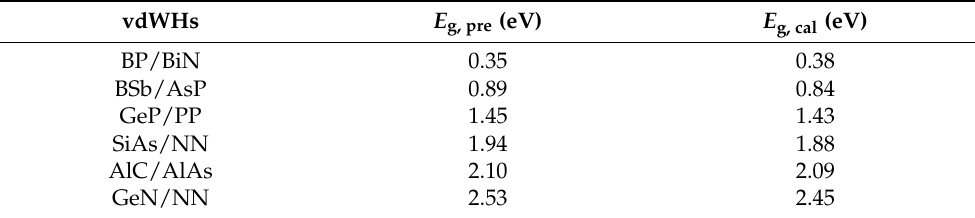
Table 2. Comparisons of the SISSO-predicted band gaps and those calculated by first-principles (HSE scheme), for six randomly selected vdWHs beyond the original dataset.